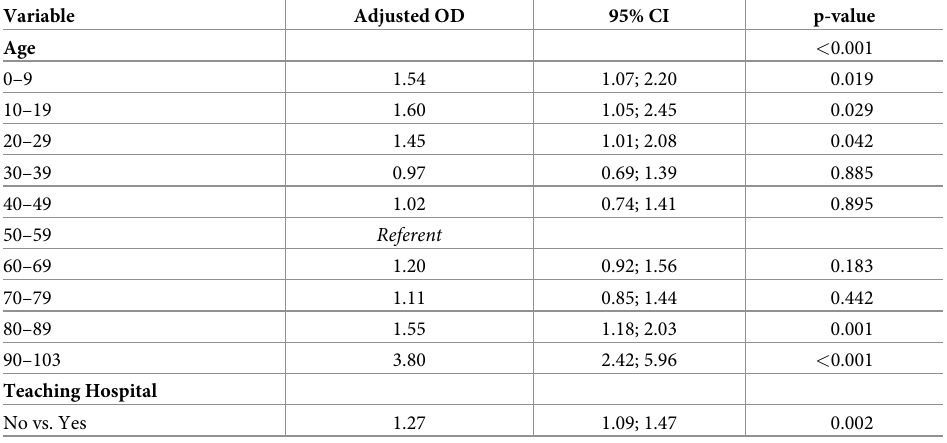
Table 3. Probability of potentially avoidable transfers correlated with hospital